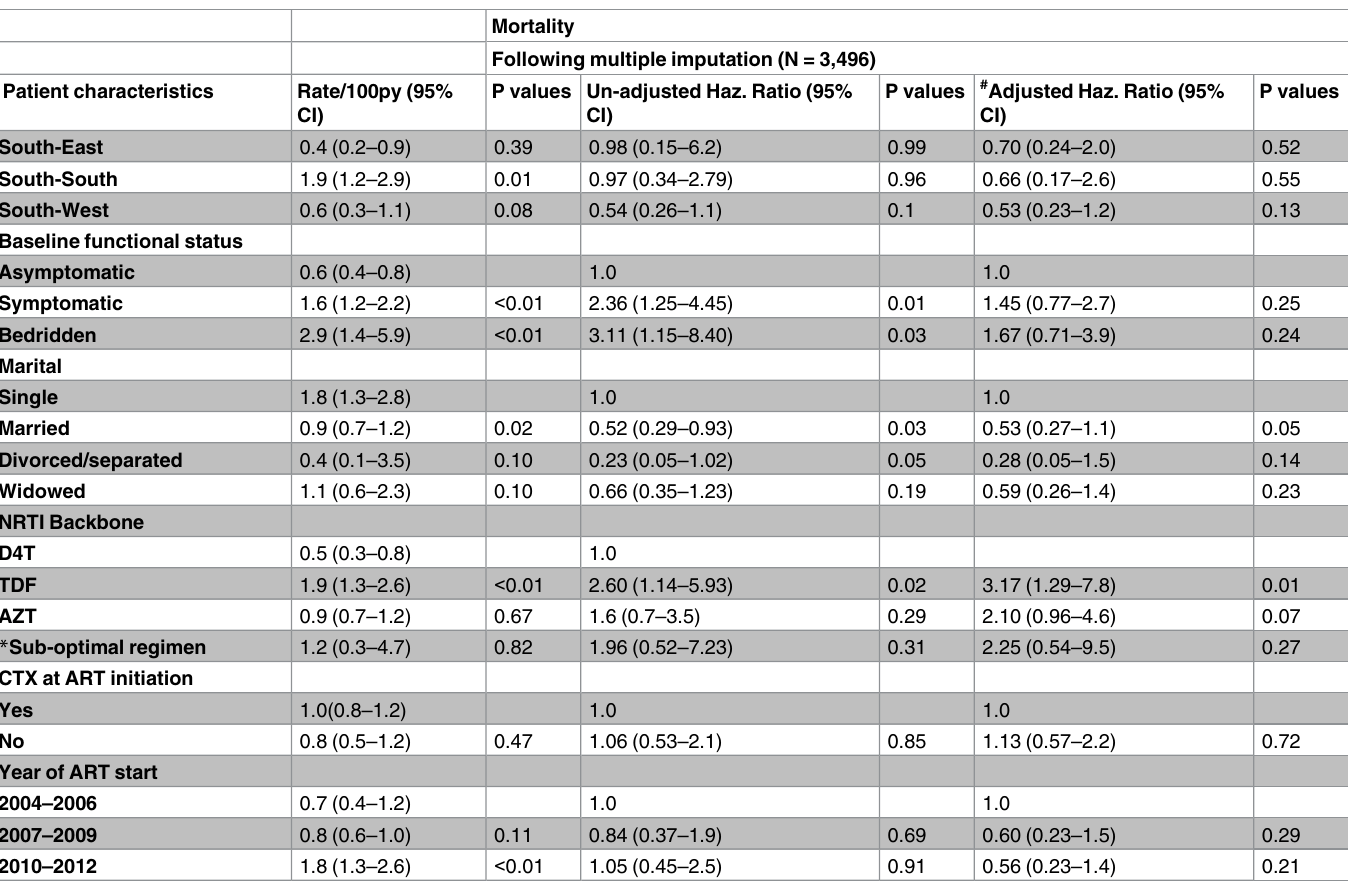
a lower probability of retention throughout the evaluation period (p < 0.01). Patients with base- line weight less than 45kg were the least likely to be retained on ART throughout the review period (p < 0.01) (Fig 4). When retention was stratified by ART regimen (Fig 5), patients receiving regimen that were not recommended by guidelines had the least probability of reten- tion (p <